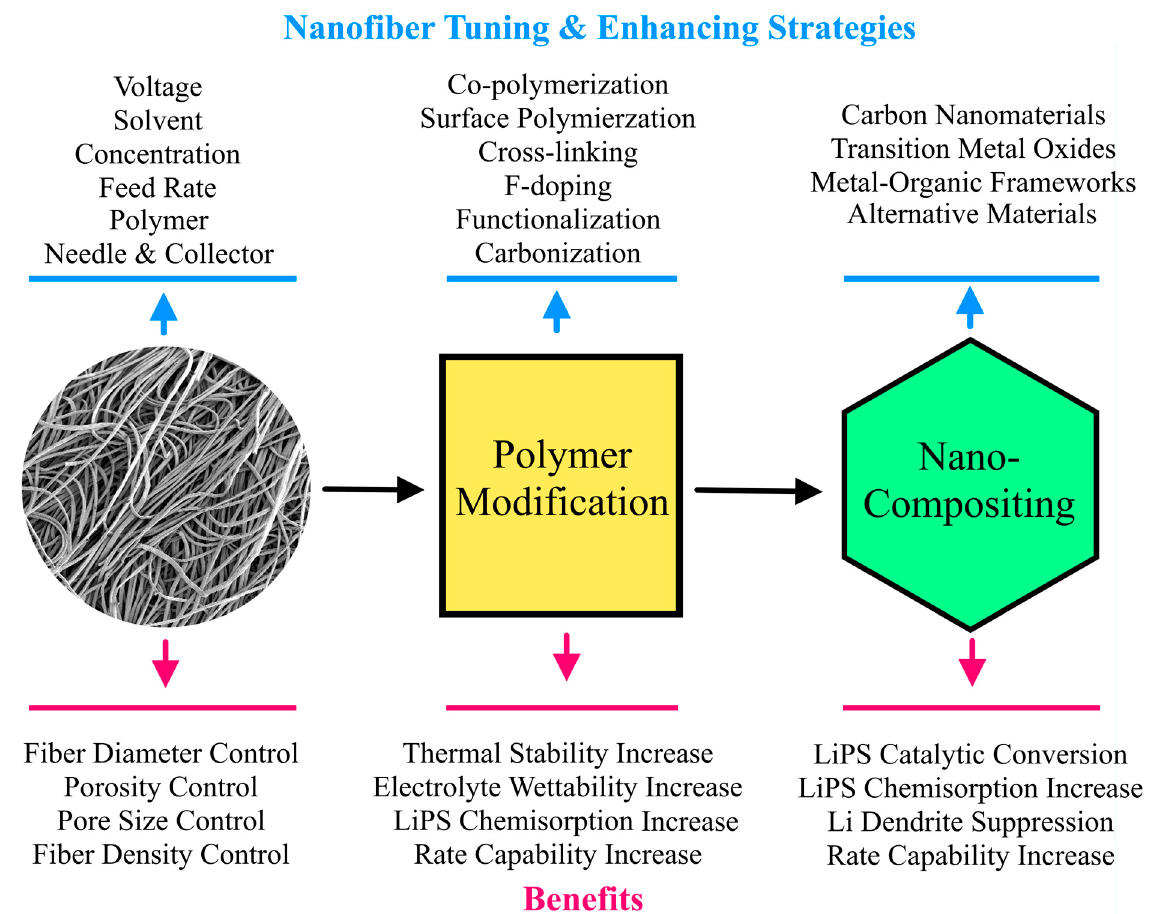
Figure 1. Schematic summarizing the strategies for tuning and enhancing NFs for LSBs via polymer modification and nanocompositing. The benefits of modifying NFs for LSBs are also summarized.